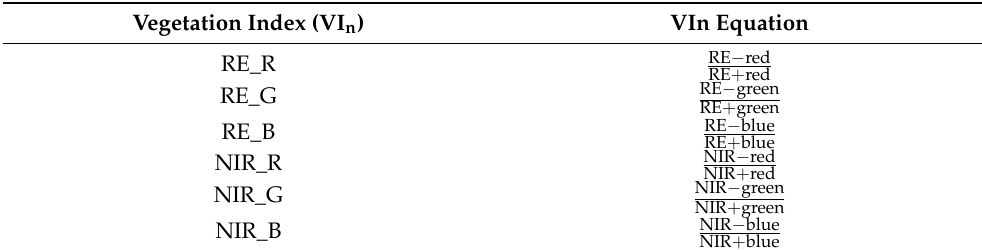
Table 4. Vegetation indices calculated from simulated multispectral data. Vegetation Index (VI n